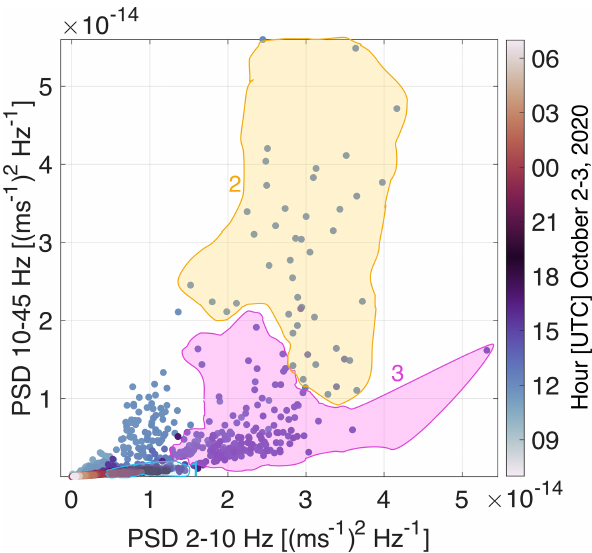
Figure B8. The same plot as Fig. 2g but on a linear scale. Seismic power calculated in 2–10Hz versus seismic power calculated in 10–45Hz at the SPIF station. The seismic power peaks are marked in different